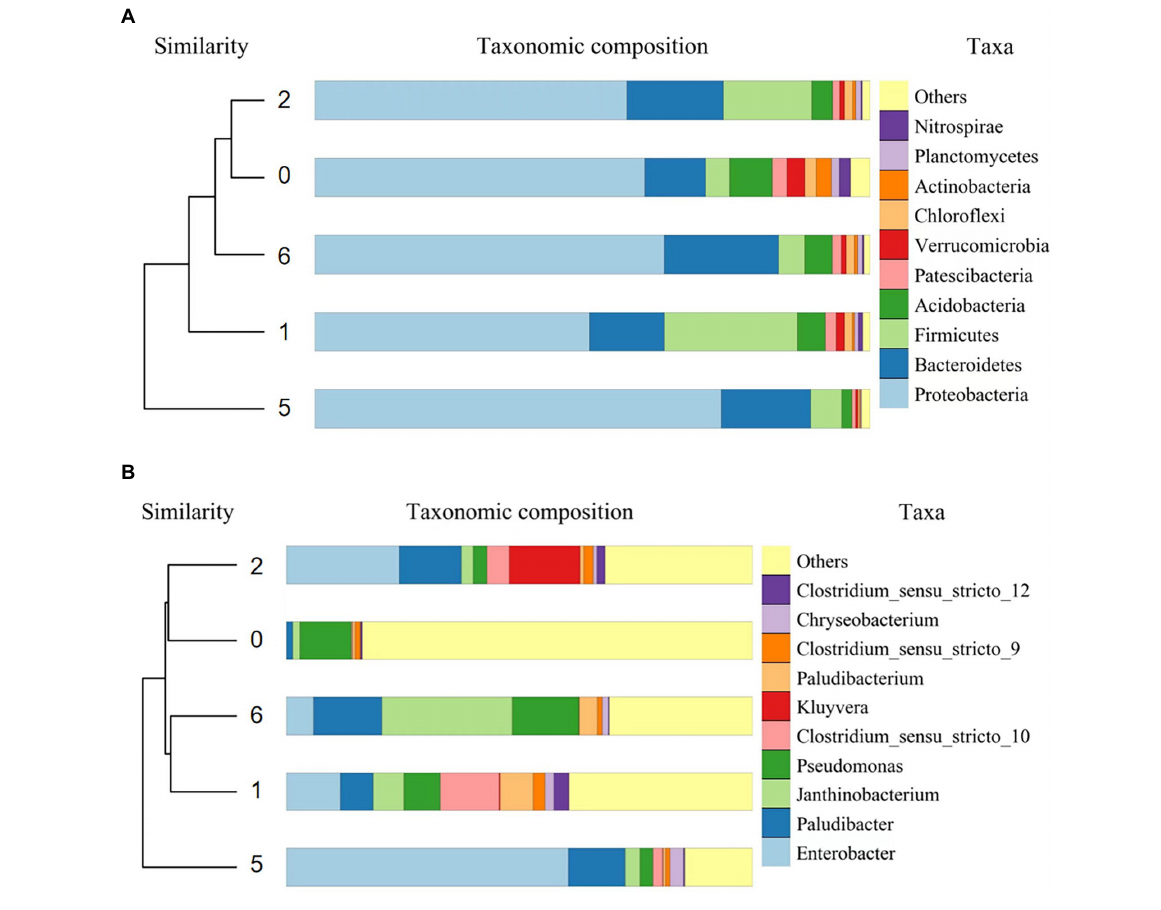
FIGURE 4 Dendrograms of the bacterial phylum-level UPGMA (A) and genus-level UPGMA (B) in the microcosmic